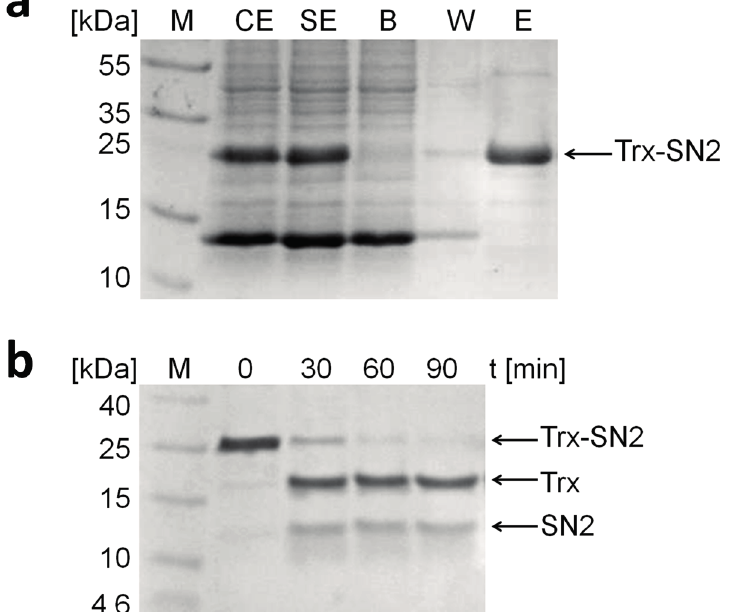
Figure 2. SDS-PAGE analysis (12%) of the purification steps of the Trx-SN2 fusion protein. ( a ) CE is the crude and SE is the soluble protein extract derived from the E. coli lysate. B represents the binding step in which the fusion protein is bound to the column; W shows the washing step; and E the final elution step where the purified fusion protein is released from the column. M is the protein molecular weight marker (Fermentas, Germany); ( b ) SDS-PAGE analysis (12%) of the cleaving activity of the TEV protease on the Trx-SN2 fusion protein. After 90 min, the fusion protein is cut into two parts. The band at 17.6 kDa represents Trx and the one appearing at 12.5 kDa represents SN2. For possible explanations of the aberrant migration behavior of SN2 (Mr = 7.1 kDa), see